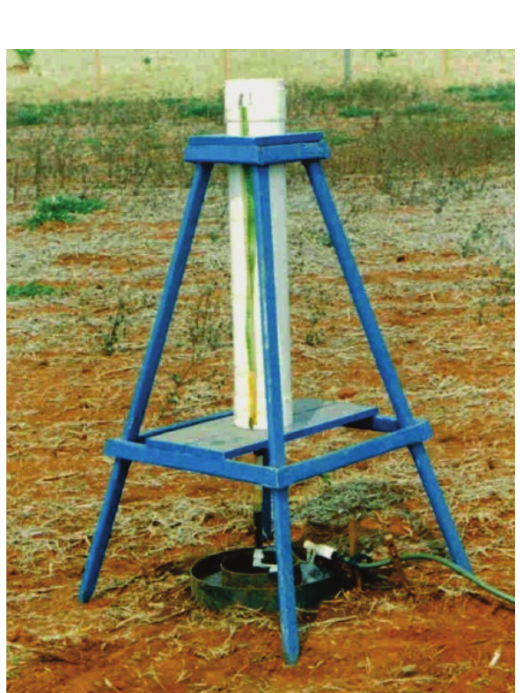
Figura 1. Detalhe dos anéis, da estrutura e das boias utilizadas na determinação da velocidade de infiltração básica (VIB) e infiltração acumulada de água no solo.